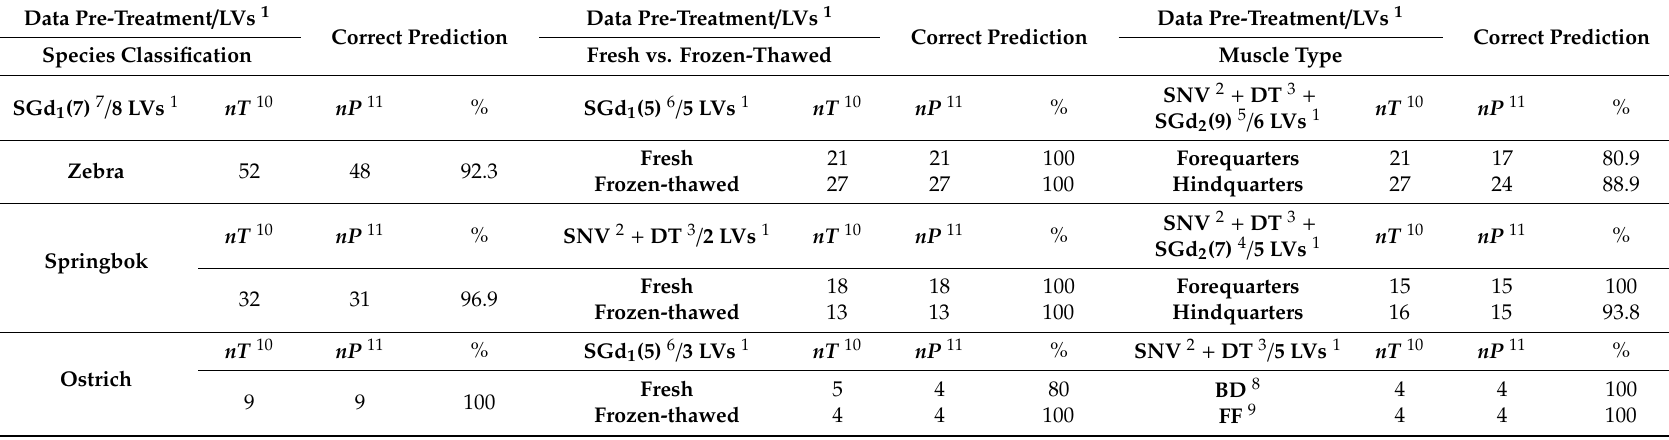
Table 4. An overview of the accuracies of the PLS-DA models with various pre-processing techniques applied to distinguish between the muscle types. Data Pre-Treatment / LVs